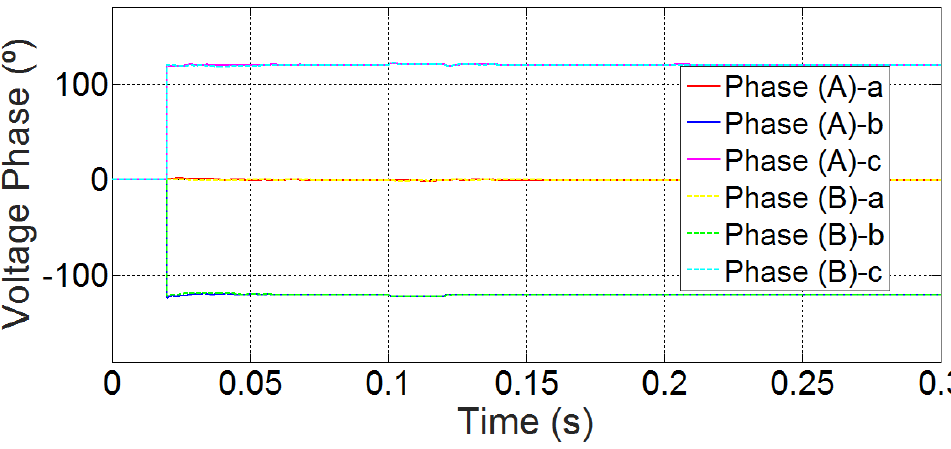
Figure 10. Absolute voltage phase angle value per phase and microgrid in mode interconnected and grid-islanded.